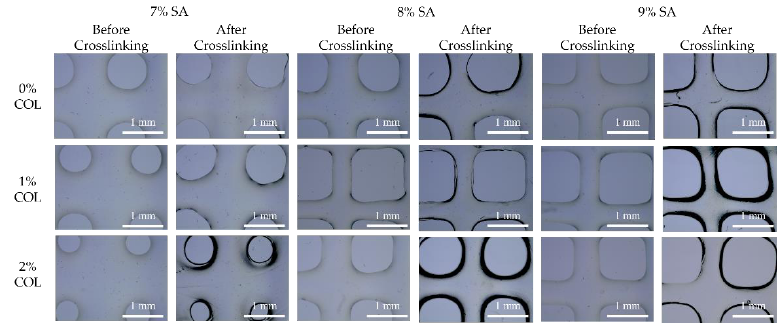
Figure 7. Images of printed grids before and after crosslinking.